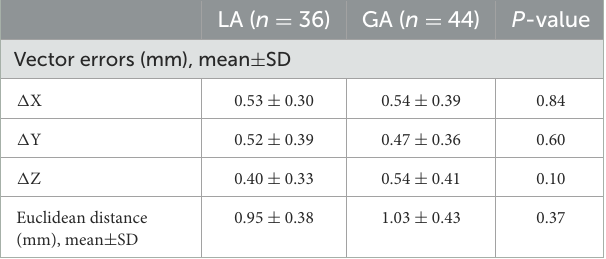
TABLE 3 Electrode implantation accuracy.